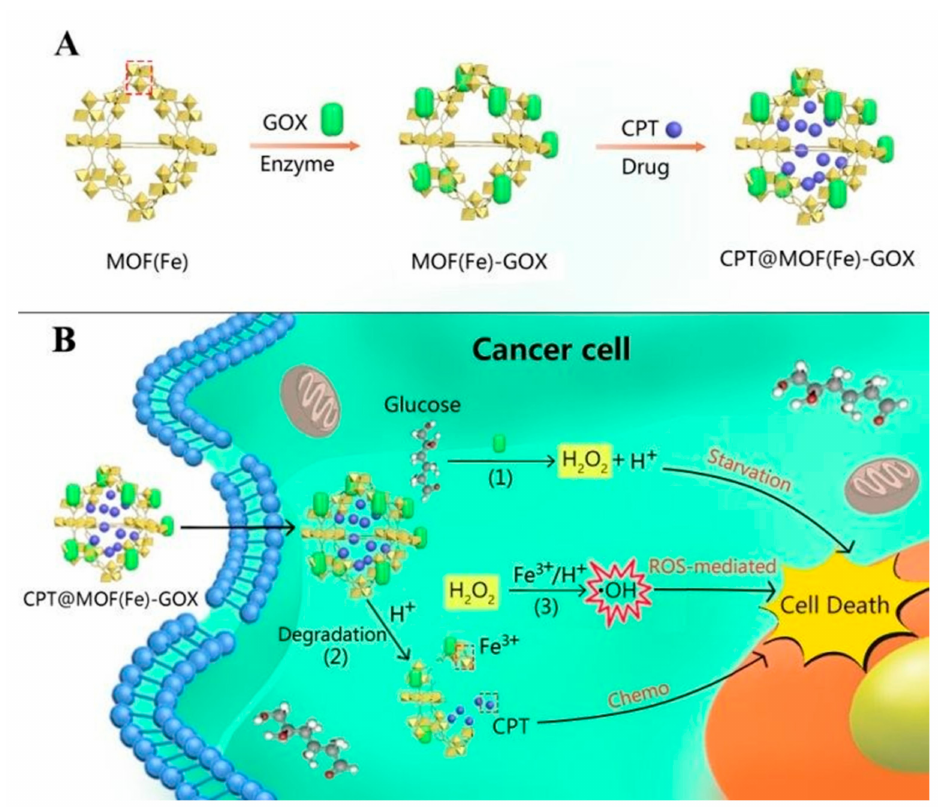
Figure 7. ( A ) Synthetic procedure of CPT@MOF(Fe)-GOX. ( B ) Schematic illustration of CPT@MOF(Fe)-GOX via a cascade reaction (1–3) in cancer cells. Adapted from